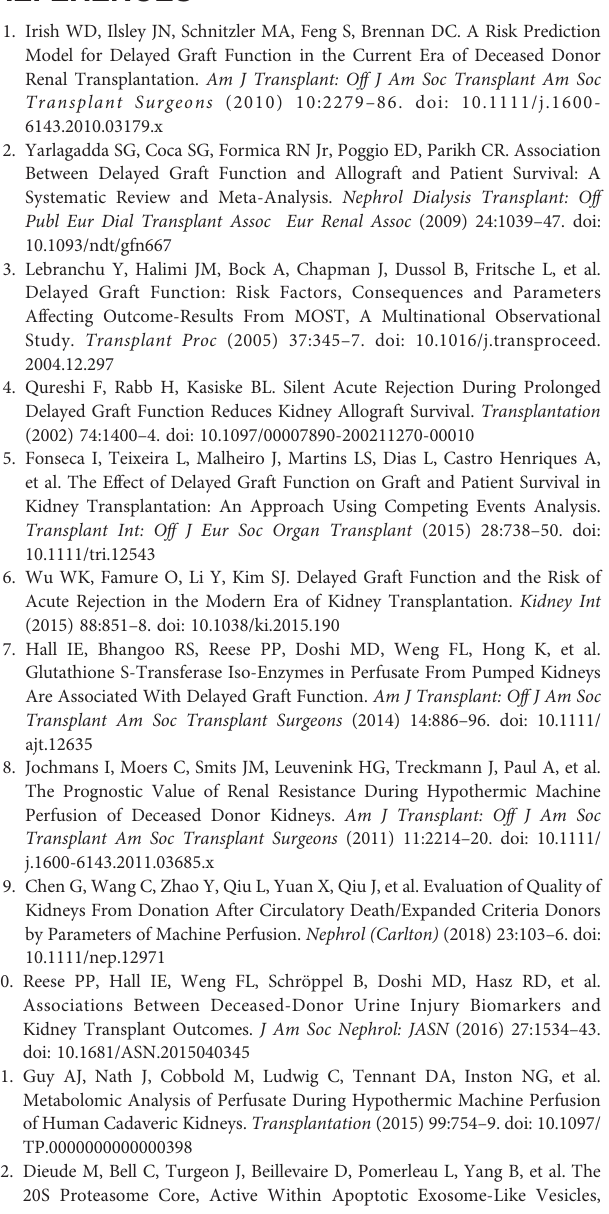
Supplementary Figure 1 | Representative plots for Cyto fl ex small particle fl ow cytometry. (A) CTDR+ KP-EV were gated, followed by gating for CD9-PE, CD63- PE, HLA-DQ-PE, HLA-A2-PE and HLA-DR. (B) HLA-A2-PE expression in KP-EV of an HLA-A2 negative donor and HLA-A2 positive donor. Supplementary Figure 2 | Expression of miR-151-b in KP-EV correlations with recipient eGFR. (A – F) Correlation of KP-EV miR-151-b expression levels as